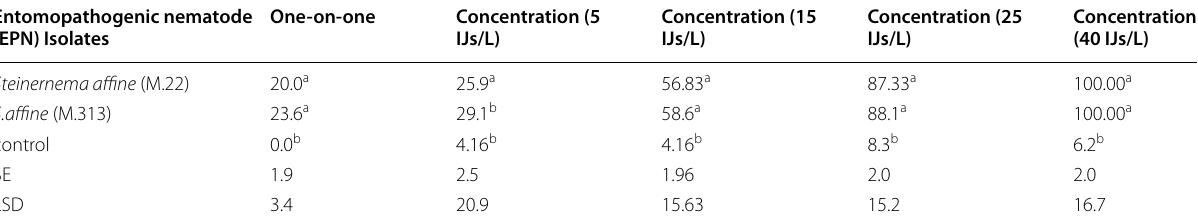
Table 5 Mortality of Galleria mellonella by Steinernema affine (M.22 and M.313) in the concentration–response and one-on-one assays at ( P < 0.01)